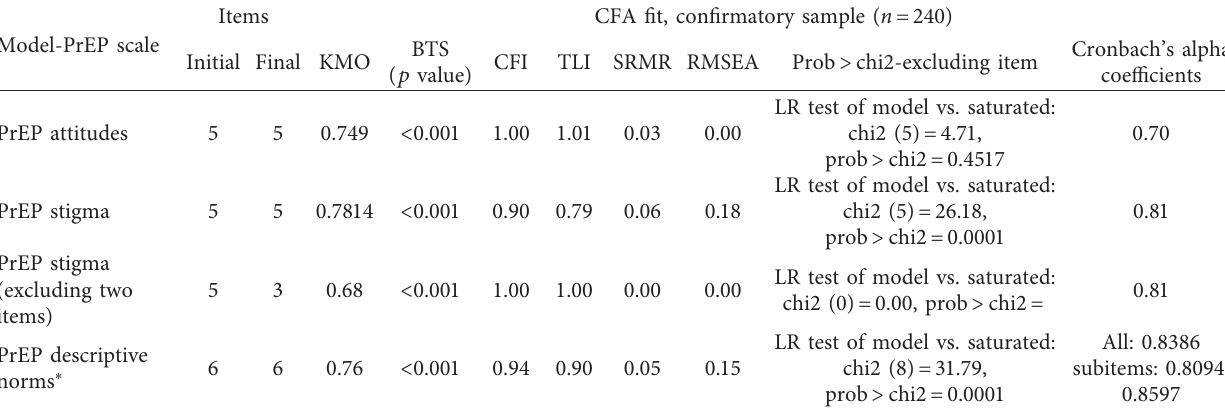
Table 4: The confirmatory factor analysis of the scales